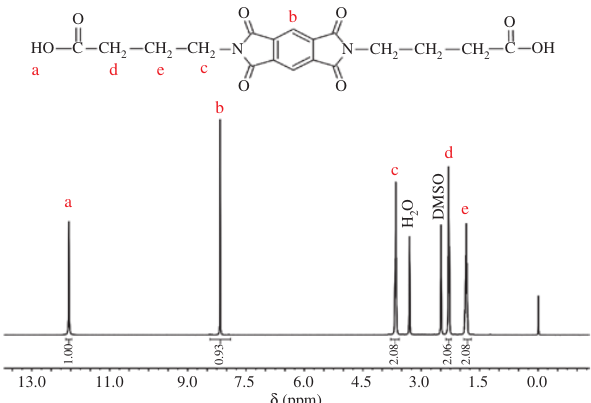
Figure 2: 1 H-NMR spectrum of diacid based on 4-aminobutyric